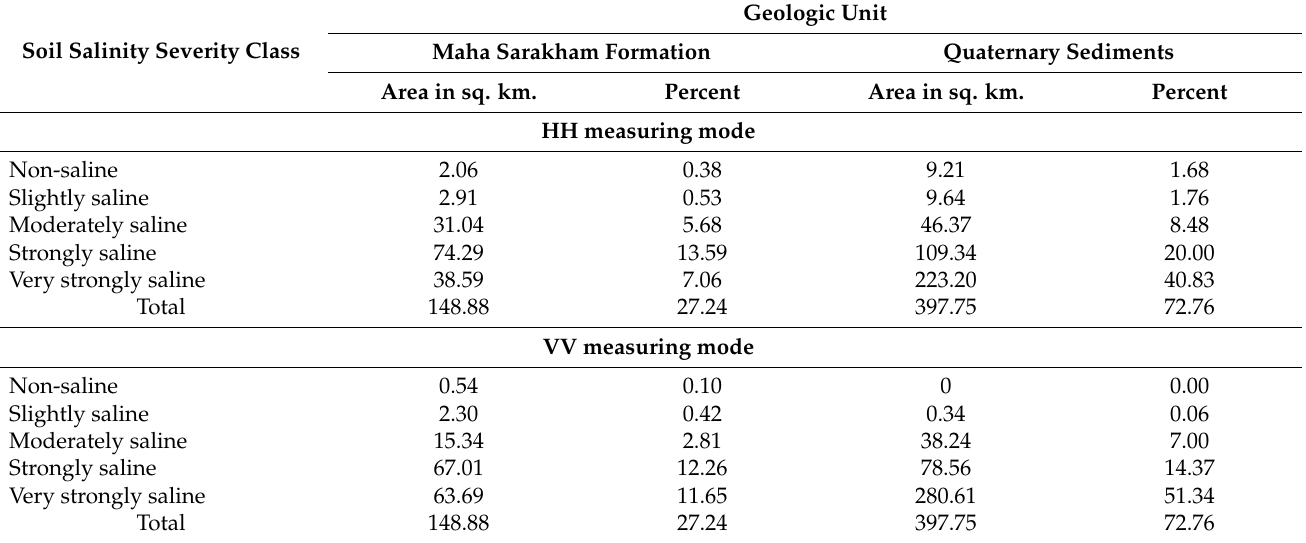
Table 19. Area and percentage of the geologic unit and soil salinity severity classification in the two measuring modes.